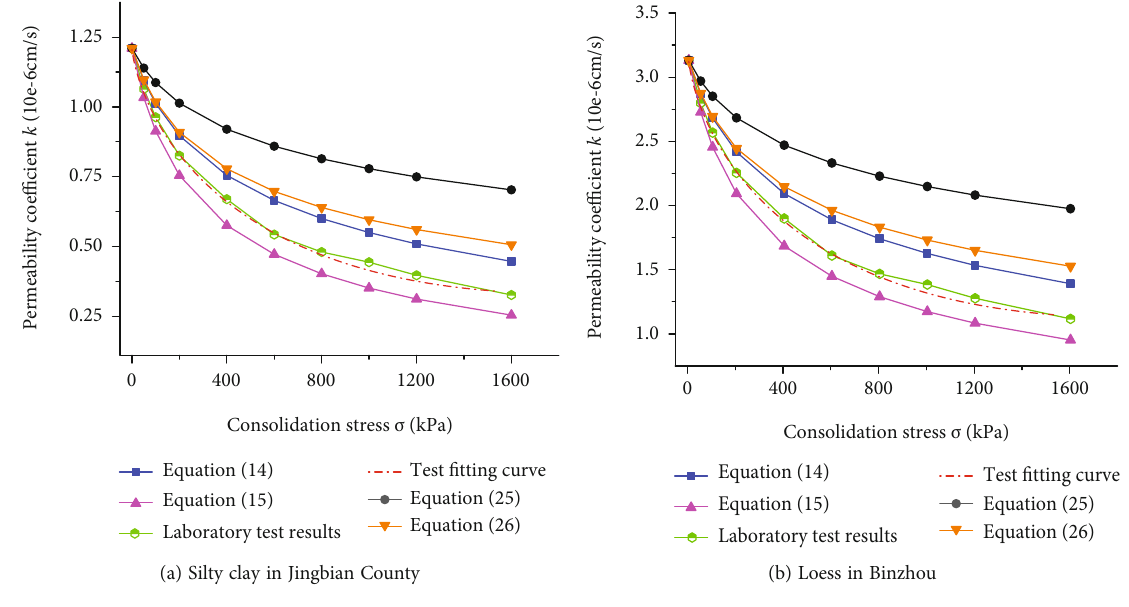
Figure 5: Relation curves between the permeability coe ffi cient and consolidation